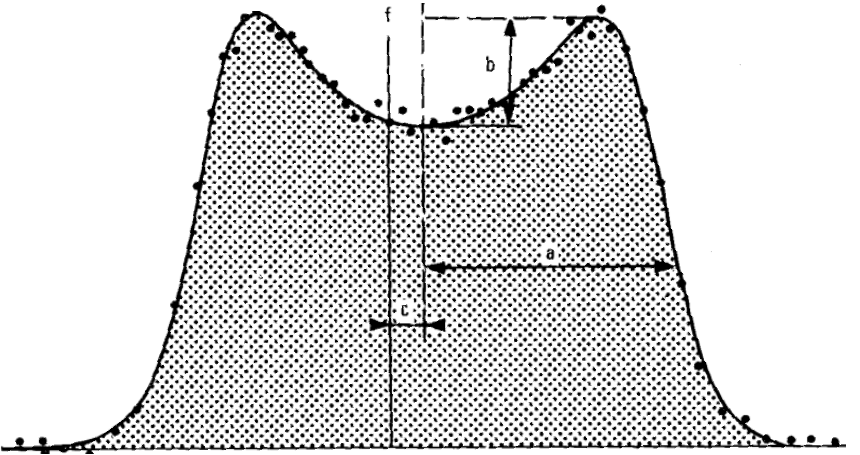
Figure 2. Best fit of an incoherent scatter spectrum to experimental data points. Parameters being fitted are the width “a”, which depends on the electron temperature and the ion mass, the shoulder height “b”, which is mainly a the ratio of electron to ion temperature, and the shift “c” from the transmitted frequency (here exaggerated for the benefit of